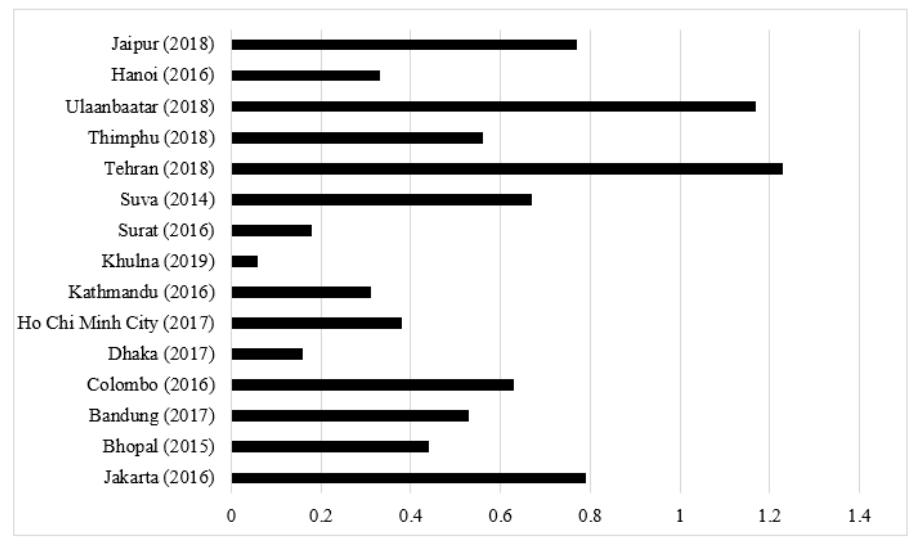
Figure 1. CO 2 emissions from transport in Asian cities (Tonnes per capita). Source: Compiled from [54]. Figure 1. CO2 emissions from transport in Asian cities (Tonnes per capita).